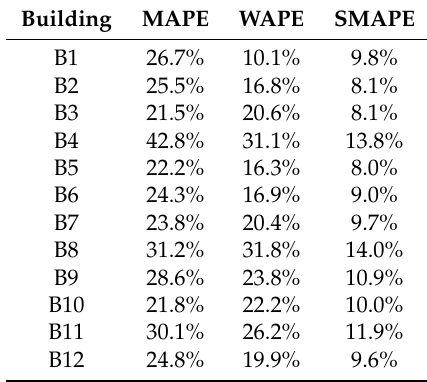
Table 4. Prediction error for each building: ridge regression model, time frame: 6 a.m–10